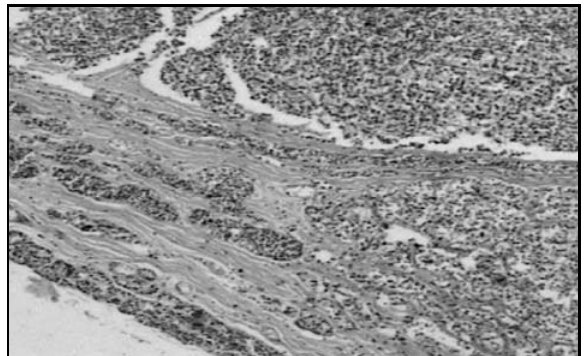
Figura 4 – Adenoma de paratireóide (HE